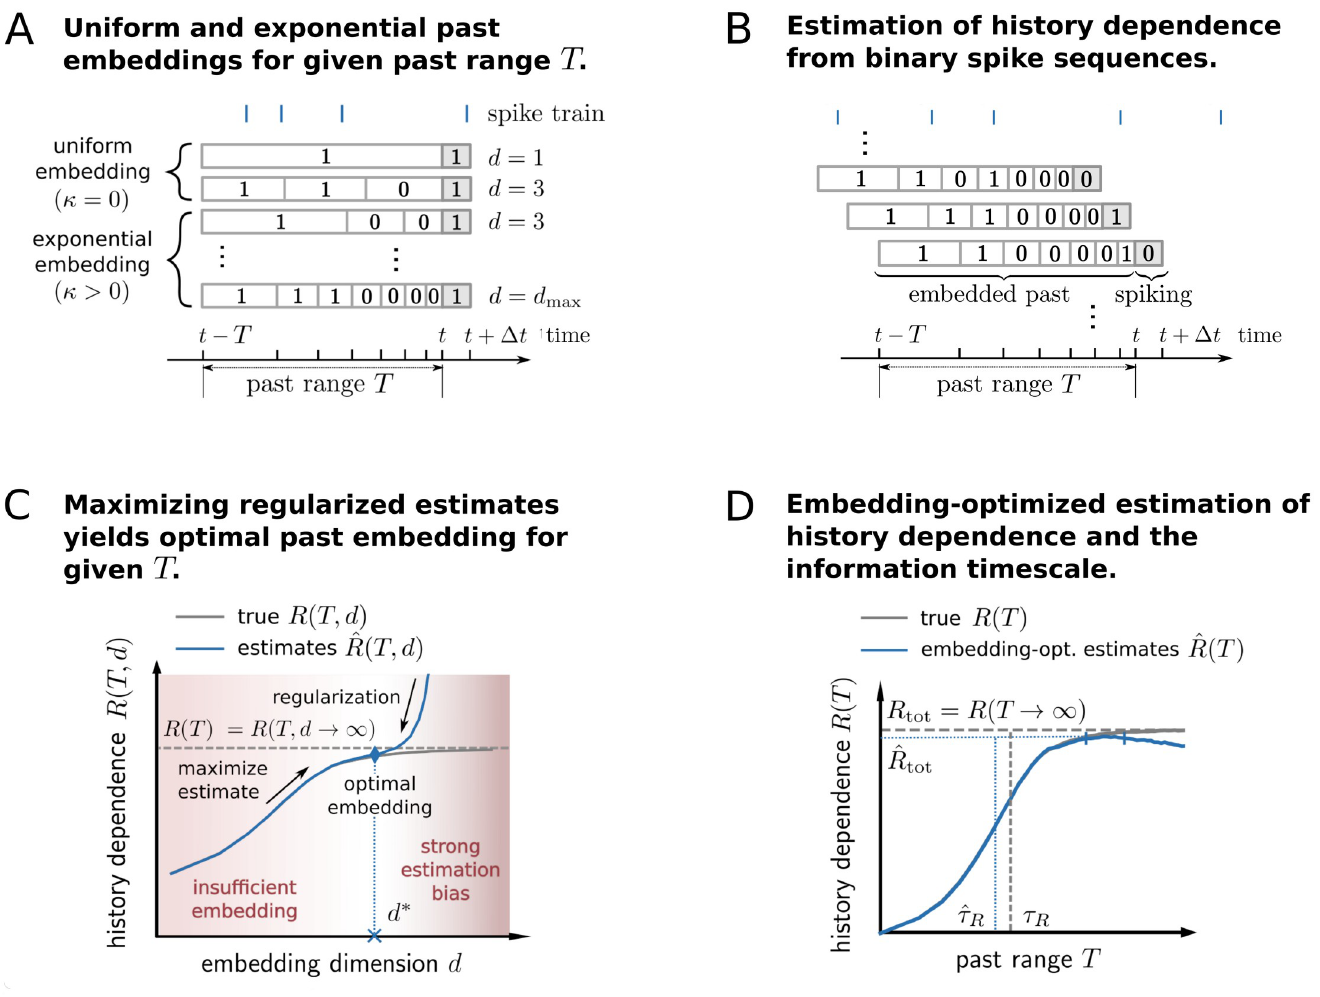
Fig 2. Illustration of embedding optimization to estimate history dependence and the information timescale. (A) History dependence R is estimated from the observed joint statistics of current spiking in a small time bin [ t + Δ t ) (dark grey) and the embedded past, i.e. a binary sequence representing past spiking in a past window [ t − T , t ). We systematically vary the number of bins d and bin sizes for fixed past range T . Bin sizes scale exponentially with bin index and a scaling exponent κ to reduce resolution for spikes farther into the past. (B) The joint statistics of current and past spiking are obtained by shifting the past range in steps of Δ t and counting the resulting binary sequences. (C) Finding a good choice of embedding parameters (e.g. embedding dimension d ) is challenging: When d is chosen too small, the true history dependence R ( T ) (dashed line) is not captured appropriately (insufficient embedding) and underestimated by estimates ^ R ð T ; d Þ (blue solid line). When d is chosen too high, estimates ^ R ð T ; d Þ are severely biased and R ( T , d ), as well as R ( T ), are overestimated (biased regime). Past-embedding optimization finds the optimal embedding parameter d � that maximizes the estimated history dependence ^ R ð T ; d Þ subject to regularization. This yields a best estimate ^ R ð T Þ of R ( T ) (blue diamond). (D) Estimation of history dependence R ( T ) as a function of past range T . For each past range T , embedding parameters d and κ are optimized to yield an embedding-optimized estimate ^ R ð T Þ . From estimates ^ R ð T Þ , we obtain estimates ^ t and ^ R of the information timescale τ and total history dependence R tot R R tot (vertical and horizontal dashed lines). To compute ^ R we average estimates ^ R ð T Þ in an interval [ T , T max ], for which estimates ^ R ð T Þ reach a plateau (vertical blue D tot bars, see Materials and methods). For high past ranges T , estimates ^ R ð T Þ may decrease because a reliable estimation requires past embeddings with reduced temporal